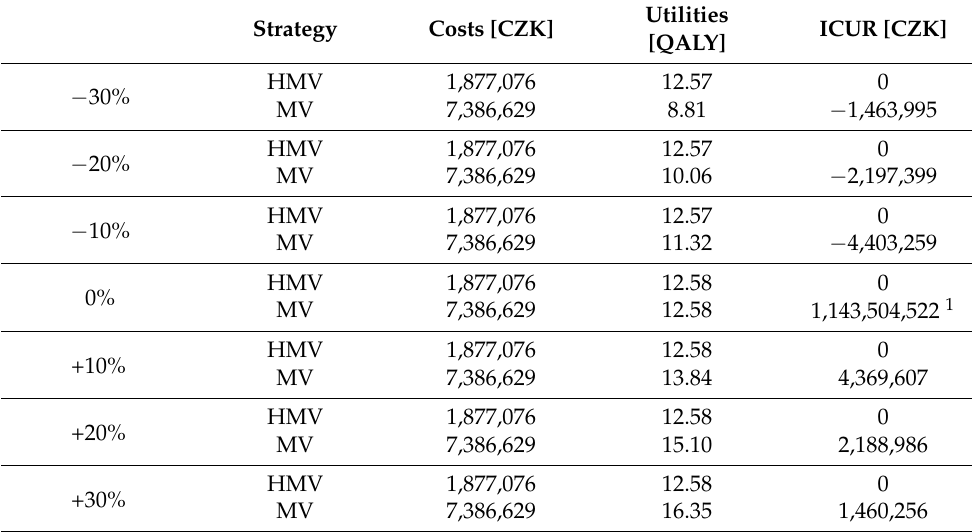
Table 8. Sensitivity analysis of utility in the healthcare